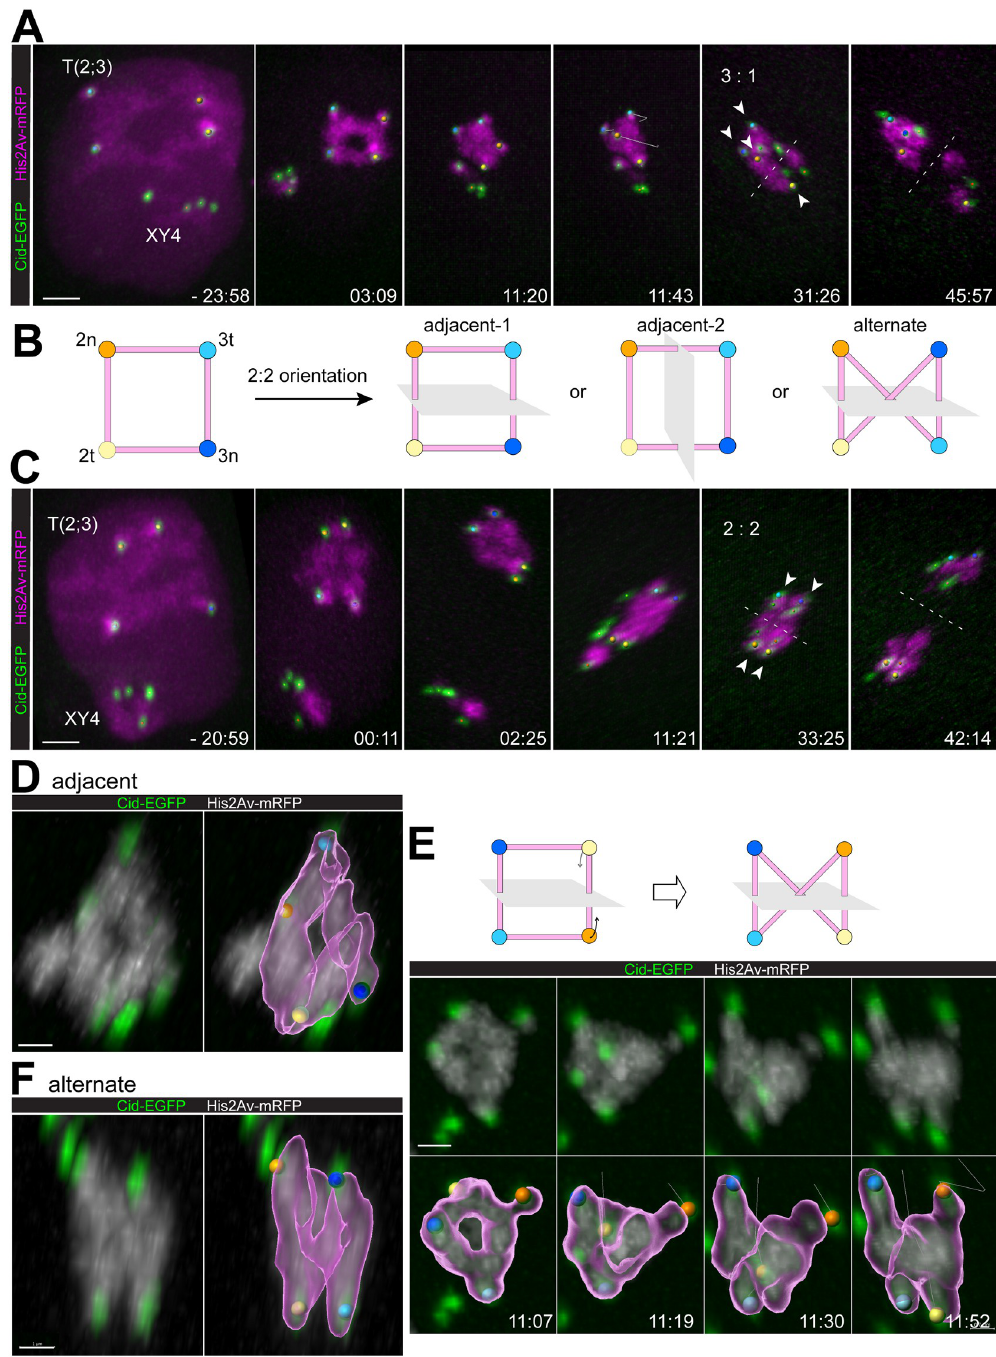
Fig 5. Alternative types of ring quadrivalent segregation during M I. Quadrivalent segregation during M I in spermatocytes heterozygous for T(2;3)ftz Rpl . His2Av-mRFP and Cenp-A/Cid-EGFP were used for time-lapse imaging. Time (min:sec) is indicated relative to the onset of NEBD I. Additional labeling as described (Fig 4A). ( A ) Still frames illustrating 3:1 segregation. ( B ) Schematic illustration of the three distinct modes of 2:2 segregation of the four centromeres of a ring quadrivalent. Centromere labeling as in Fig 4A. Grey planes represent division plane. ( C ) Still frames illustrating 2:2 segregation. ( D,F ) High magnification views of quadrivalents in metaphase I (spindle axis within image plane from top to bottom). The four associated centromeres are bi-oriented in either adjacent ( D ) or alternate ( F ) configuration. His2Av-mRFP isosurface representations of quadrivalent chromatin with centromeres marked by colored spheres are shown on the right side. ( E ) Quadrivalent shape transformation from ring to anti-parallelogram for alternate centromere bi-orientation, as schematically illustrated (top). Scale bars = 3 μ m (A,C) and 1 μ m